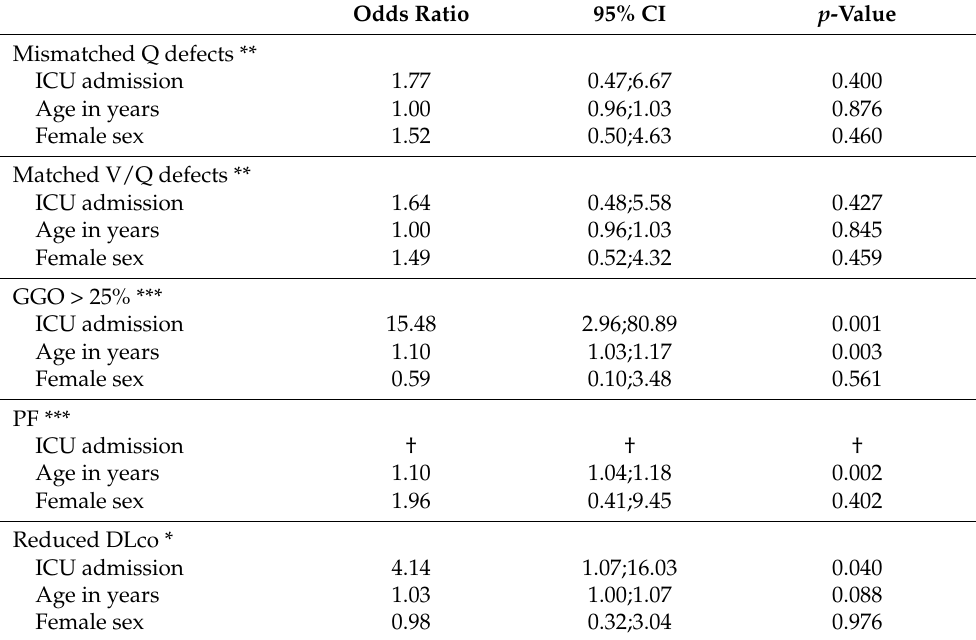
Table 6. Association between V/Q scintigraphy defects or HRCT findings or diffusion capacity with admission to ICU, age and sex in patients 4 months after COVID-19 (n = 67) using multivariable logistic regression. Odds Ratio 95% CI p